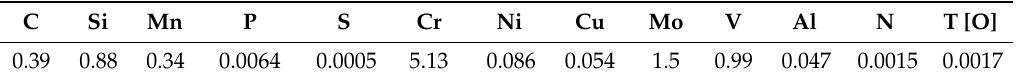
Table 1. Chemical composition of H13 steel,